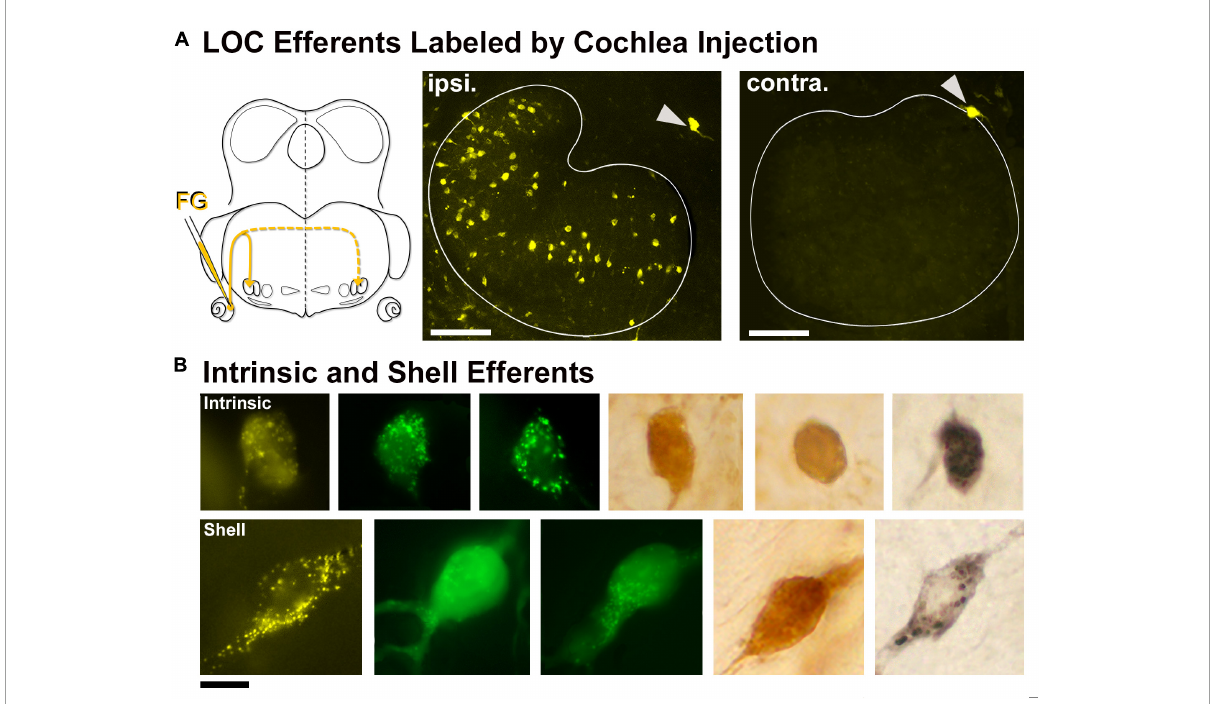
FIGURE2 Labeled lateral olivocochlear (LOC) efferents following retrograde tracer injections into the cochlea. (A) Schematic illustration of retrograde tracer injected through the round window of the left cochlea. Solid yellow line indicates the primary pathway to the ipsilateral LOCs, whereas the dashed line leads to the very few contralateral LOCs. Gray arrowheads: shell neurons on the borders of the LSO. (B) Photomicrograph (100x objective) of the intrinsic LOC efferents (top row) labeled with chromogenic development (DAB-brown, NiDAB-black) and with fluorescent markers (FG-yellow, FD-green). The intrinsic neurons were small and round, and look similar to the principal neurons. The shell neurons (bottom row) were labeled in the same tissue as the intrinsic neurons, and featured a large cell body with broader dendritic extensions. ipsi., ipsilateral; contra., contralateral; FG, fluorogold; FD, fluorescein dextran. Scale bar equals 100 µ m (A) , 25 µ m (B)